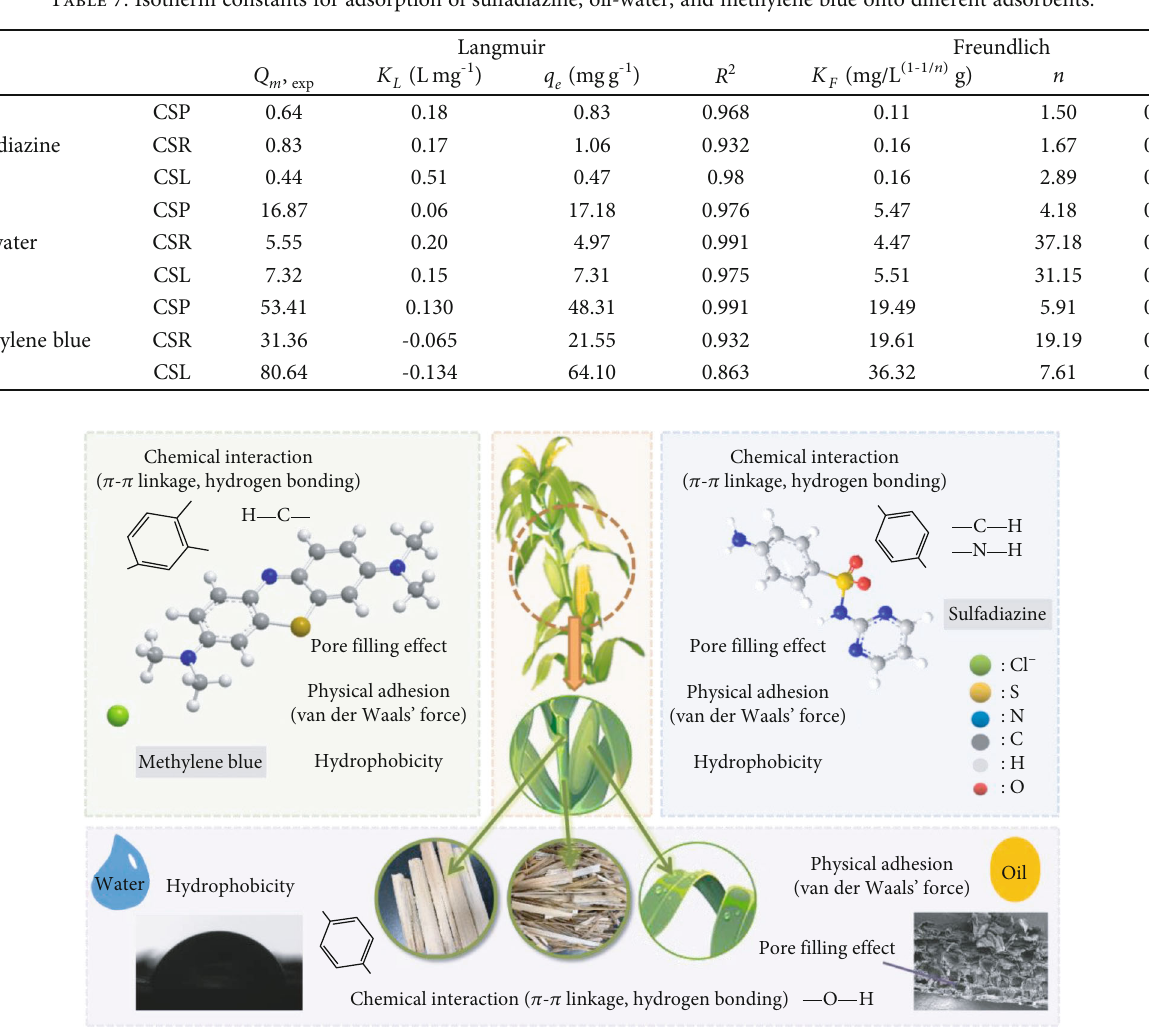
Figure 11: The adsorption mechanisms of corn stover toward